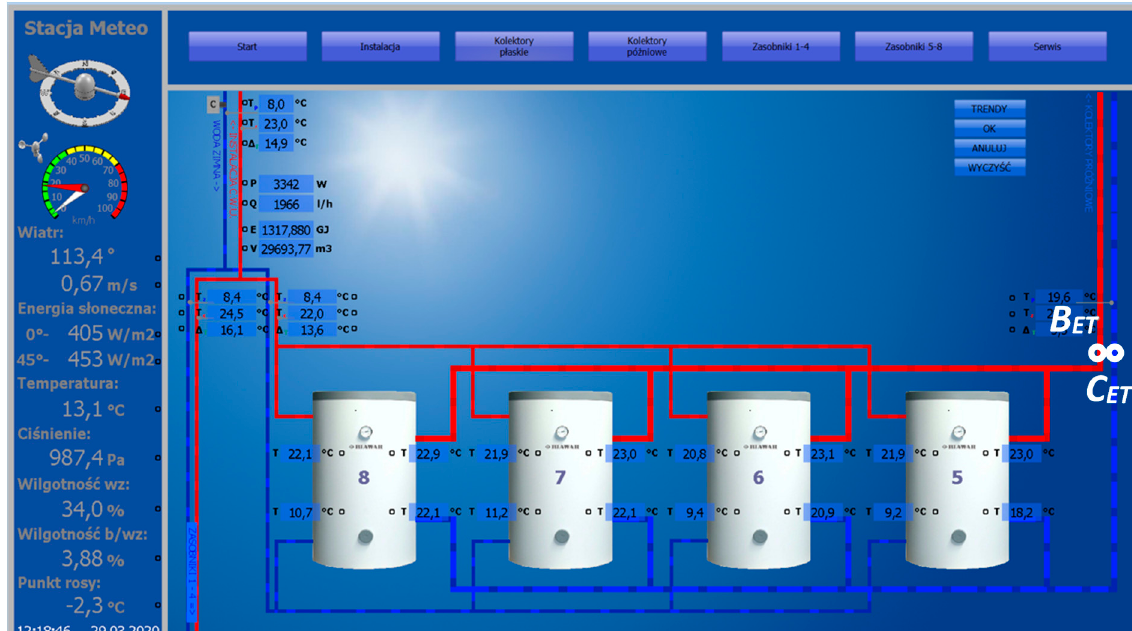
Figure 7. Screenshot of the monitoring system—tanks connected with evacuated tube solar collectors.